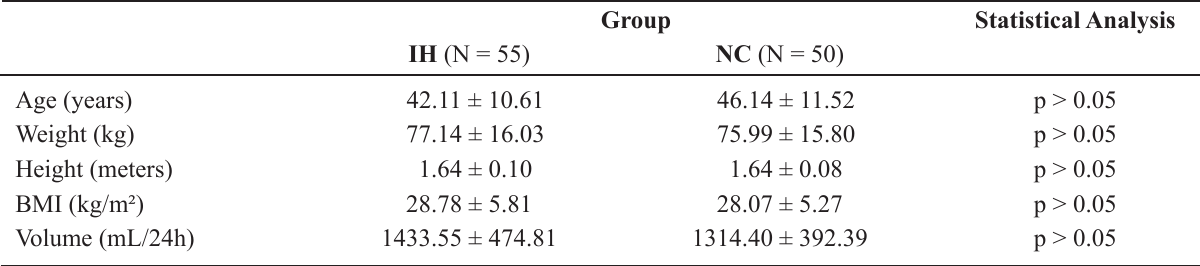
Table 1 – Demographics characteristics of the different studied groups.